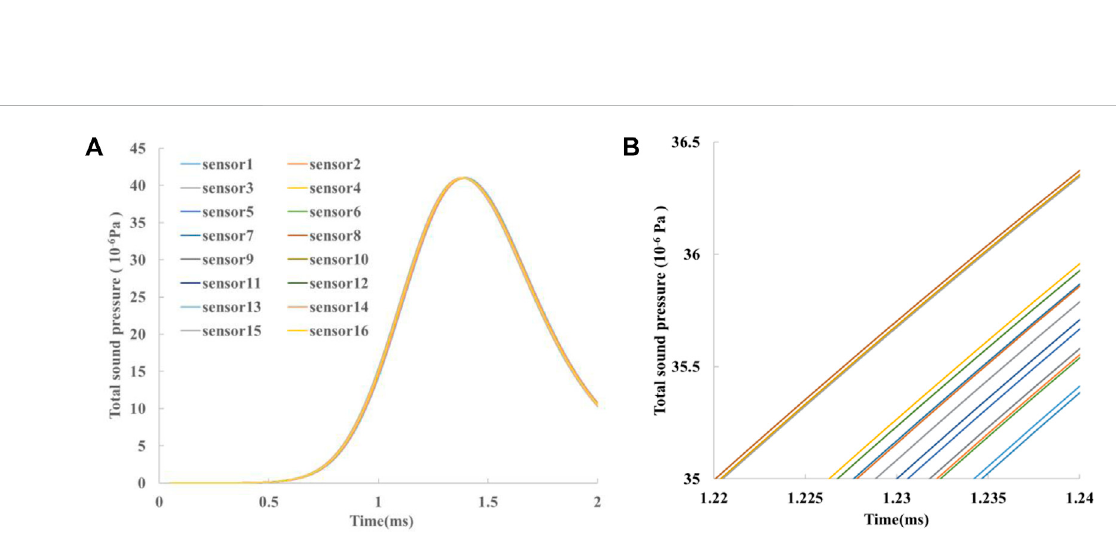
used for data processing as the basic data for analyzing the evolution of the fracturing crack propagation path in this article. A total of 127 and 137 microseismic sources were induced in the fi rst- and second-stage fracturing, respectively. Based on the microseismic monitoring data, the discrete fracture network representing the fracturing crack was generated, as shown in Figure 9. The center point of the disk is the location of the microseismic source, and the radius of the disk represents the radius of the crack, and different colors correspond to different tensile angles.